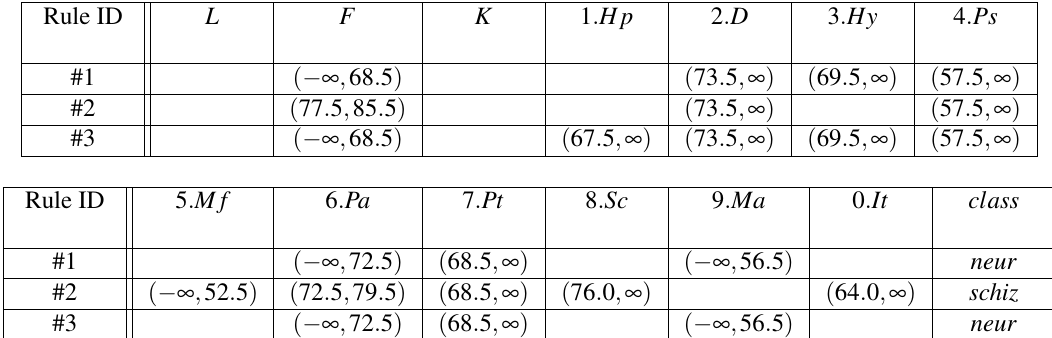
Table 2: The LEM2 rules for a data table with basic scales